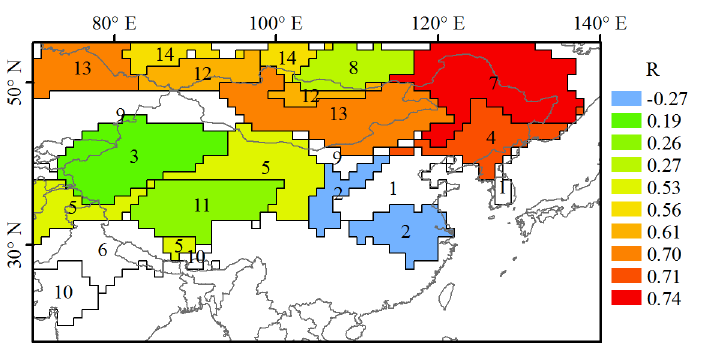
Figure 7. Correlation coefficients (R) of all clustering classes ( p -value < 0.05) between the Xco amplitude and NPP. 2